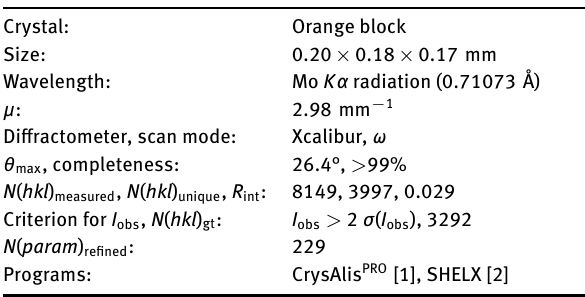
Table 1: Data collection and